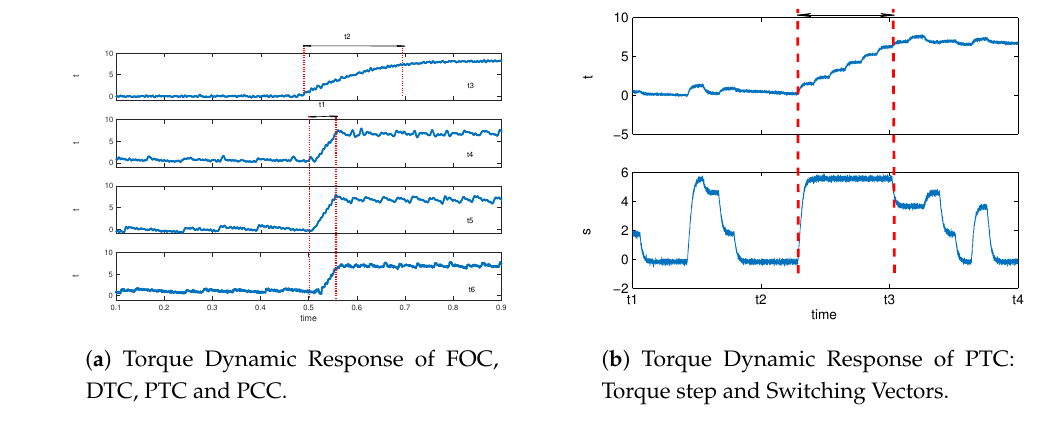
Figure 4. Torque responses of four strategies.